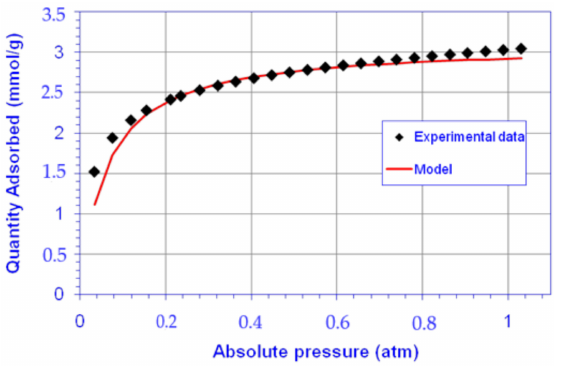
Figure 5. Experimental and Langmuir model isotherms of CO 2 adsorption onto CFAZ.